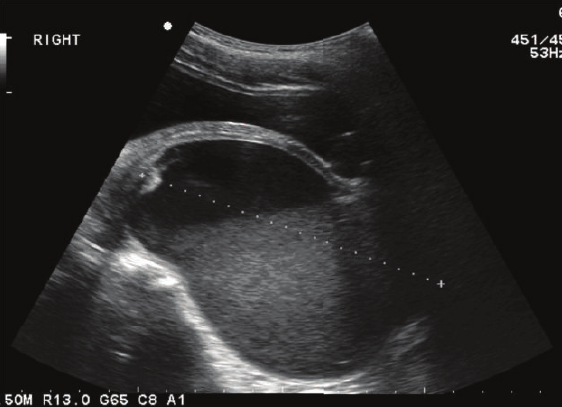
Figure 1: Ultrasound scan showing fluid-filled uterus.